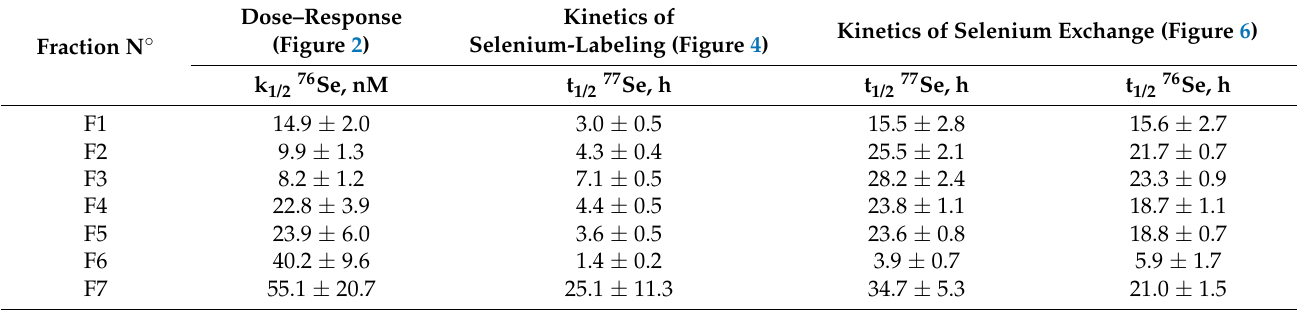
Table 2. Summary of the distinct features for each fraction collected according to the SEC-ICP MS chromatogram.